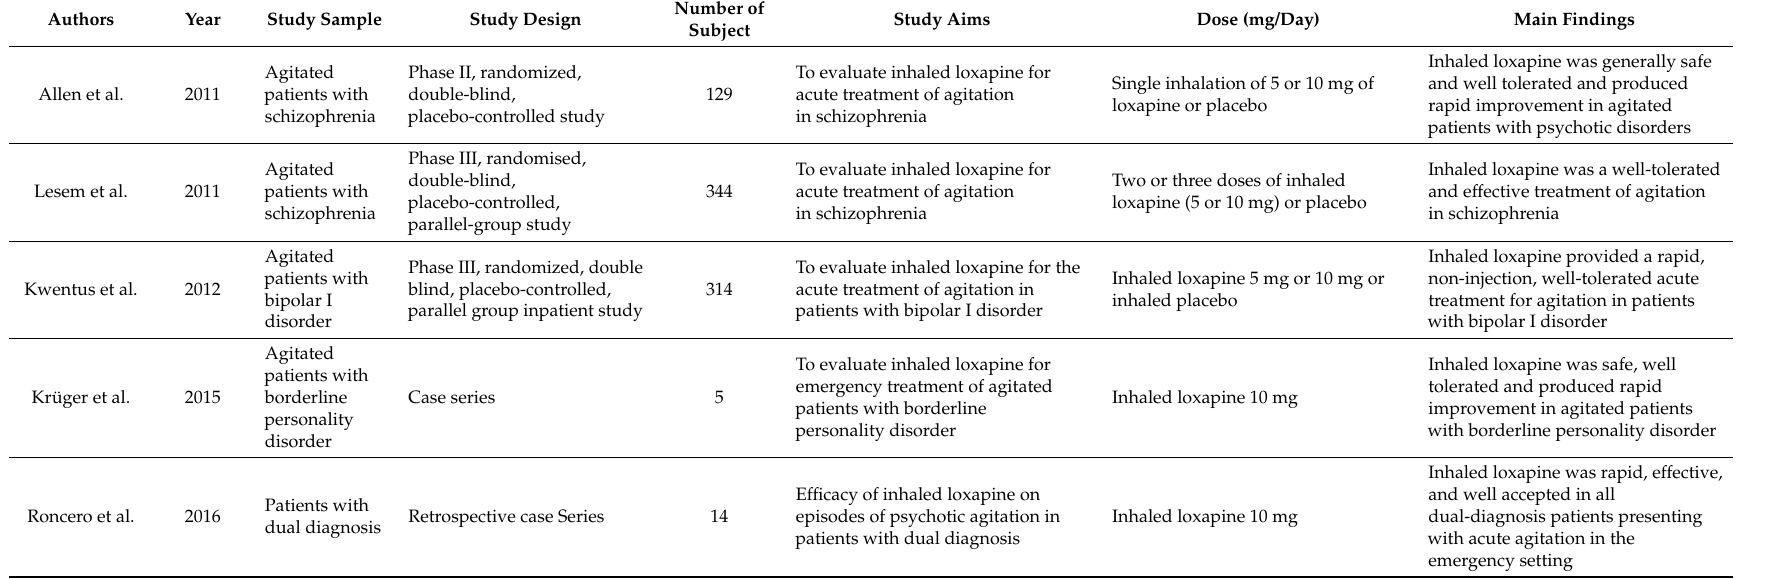
Table 3. Published studies on inhaled FGA loxapine in the treatment of agitation in psychiatric